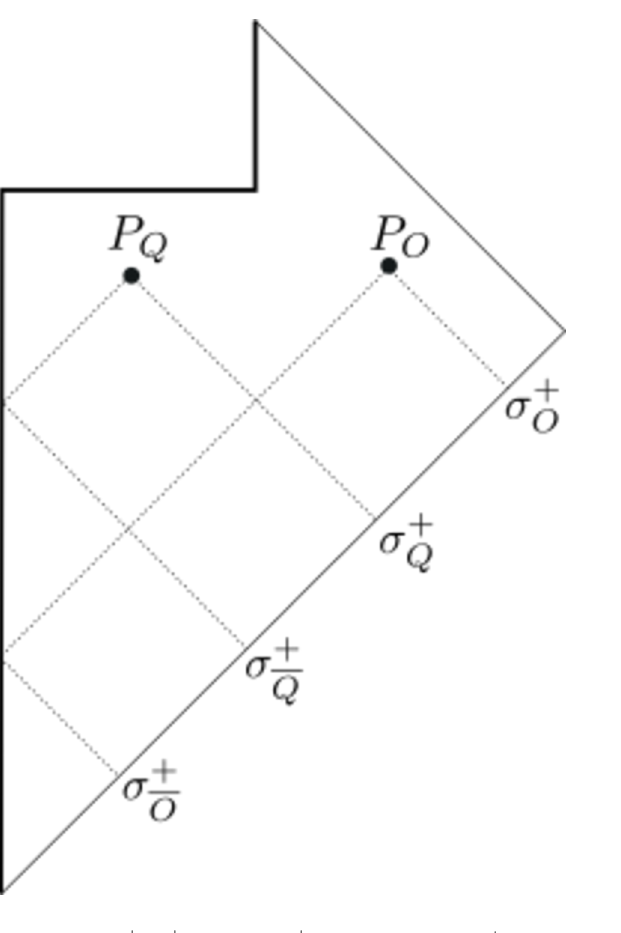
; (cid:27) + ), where (cid:27) + is the value of (cid:27) + for the image point obtained P P P